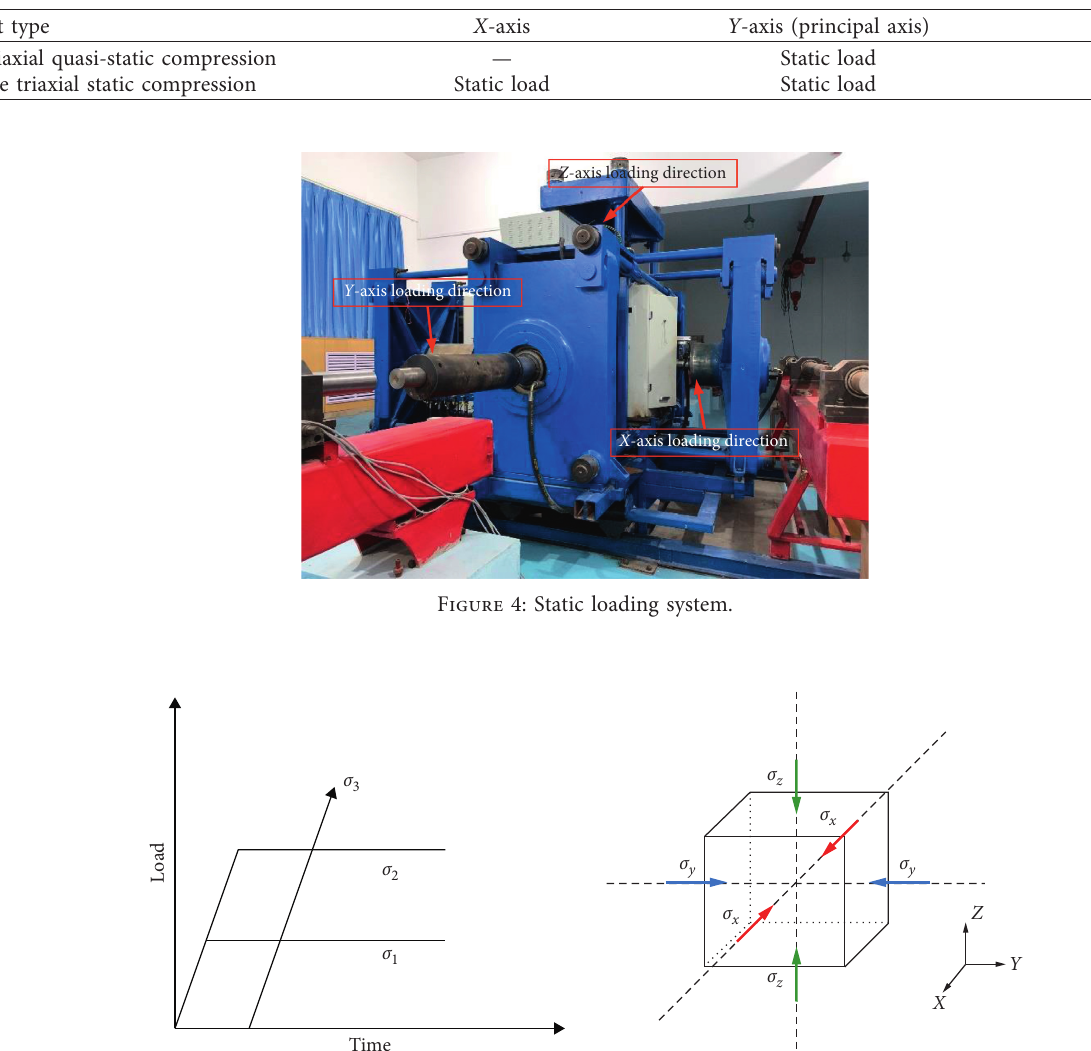
Table 5: Loading scheme of the test.